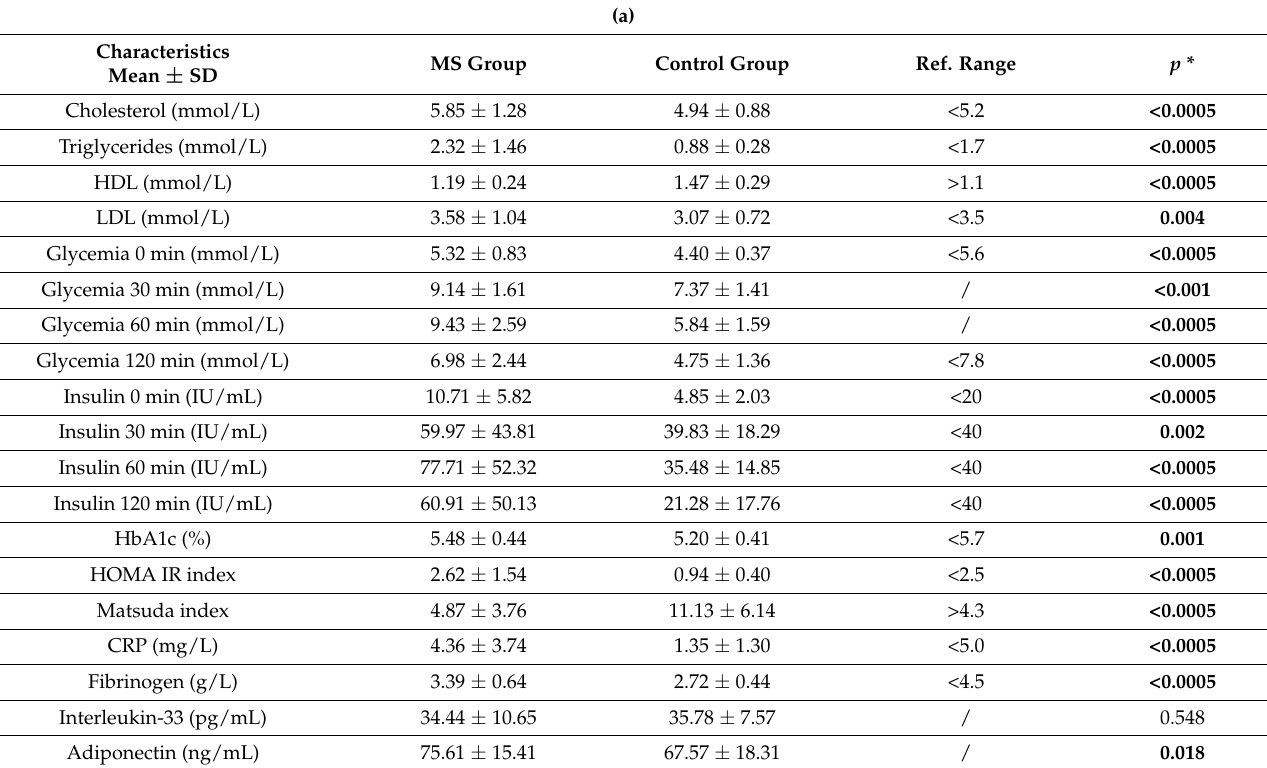
Table 2. (a) Clinical characteristics of patients with MS (n = 67) and control group (n = 45). (b). Results of covariance analysis.